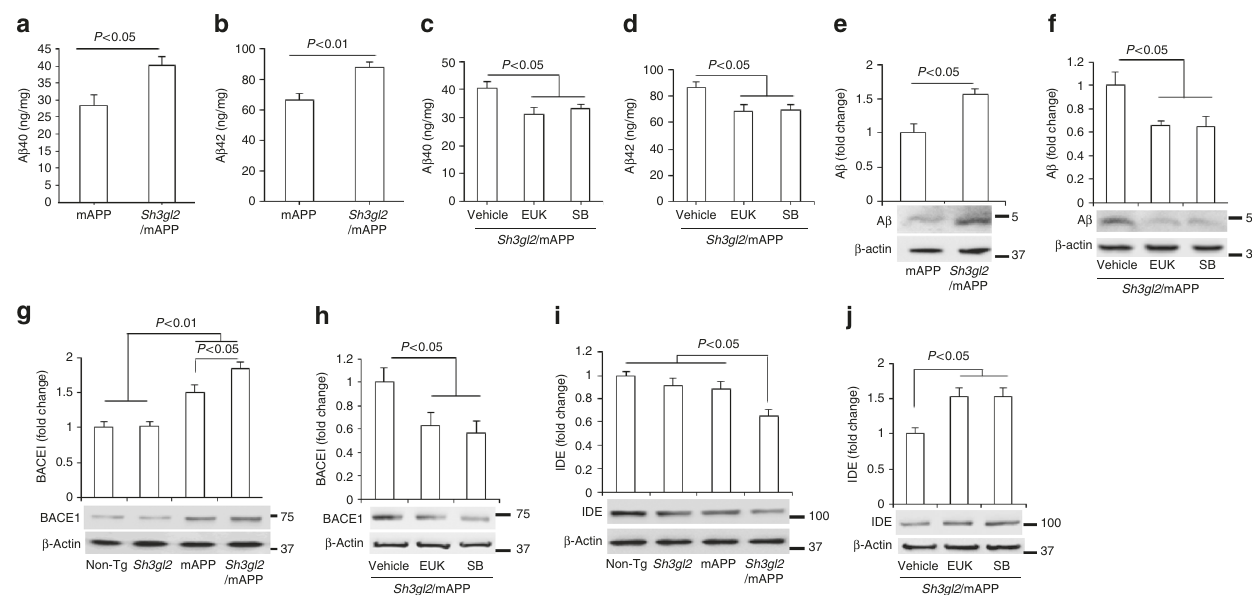
Fig. 10 Effect of EP overexpression on cerebral A β accumulation. ELISA for measurement of A β 40 ( a , c ) and A β 42 ( b , d ) in the entorhinal cortex of Tg mAPP and Tg Sh3gl2 /mAPP mice at the age of 5 – 5.5 months. EUK-134 (EUK, 2 mg/kg) ( c , d ) or SB203580 (SB, 0.5 mg/kg) ( c , d ) was administered to Tg Sh3gl2 /mAPP mice once a day for 3 weeks and then cortical tissues were subjected to A β measurement at the age of 5 – 5.5 months. Date are shown as mean ± s.e.m., n = 3 – 6 per group (one-way ANOVA in a – d ). Quanti fi cation of immunoreactive bands for A β ( e ), BACE1 ( g ), or IDE ( i ) in the indicated Tg mice at the age of 5 – 5.5 months. Quanti fi cation of immunoreactive bands for A β ( f ), BACE1 ( h ), or IDE ( j ) in Tg Sh3gl2 .mAPP mice treated with EUK or P38 inhibitor (SB) relative to vehicle treatment. β -Actin was used as a protein loading control. Lower panels are representative immunoblots for the indicated proteins in the indicated Tg mice. Date are shown as mean ± s.e.m., n = 3 per group (one-way ANOVA in e – j